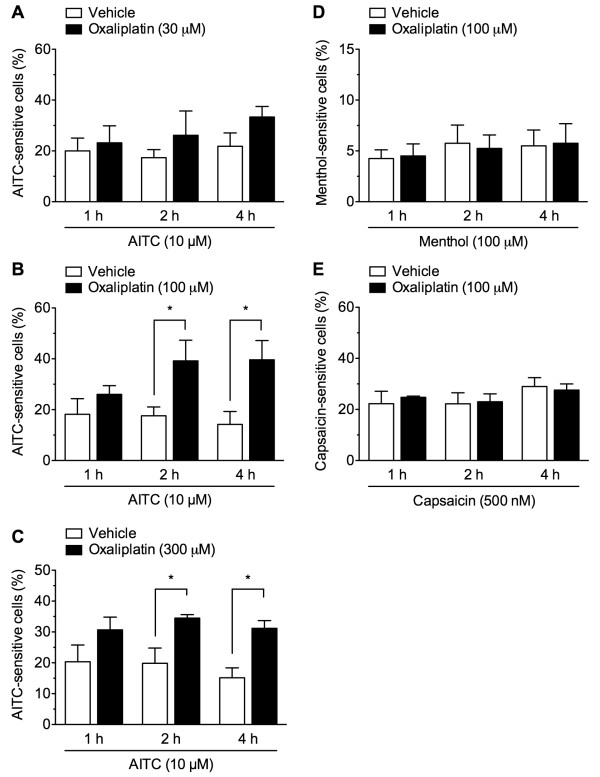
Oxaliplatin pretreatment increases the number of AITC-sensitive DRG neurons. ( A- C) In cultured DRG neurons pretreated with vehicle or oxaliplatin at concentrations of 30 ( A), 100 ( B) or 300 μM ( C) for 1, 2, or 4 h, AITC (10 μM) was added for 3 min. ( D, E) In cultured DRG neurons pretreated with vehicle or oxaliplatin (100 μM) for 1, 2, or 4 h, menthol (100 μM; D) or capsaicin (500 nM; E) was added for 3 min, and the Ca2+ responses of the neurons were determined. Cells were considered responsive if their F340/F380 ratio increased by more than 0.2 during the 3-min application. The values show the percentage of agonist-sensitive cells in 50 mM KCl-positive neurons. Data are presented as the mean ± S.E.M. of 4–6 separate experiments. *p < 0.05, compared with corresponding vehicle-pretreatment.